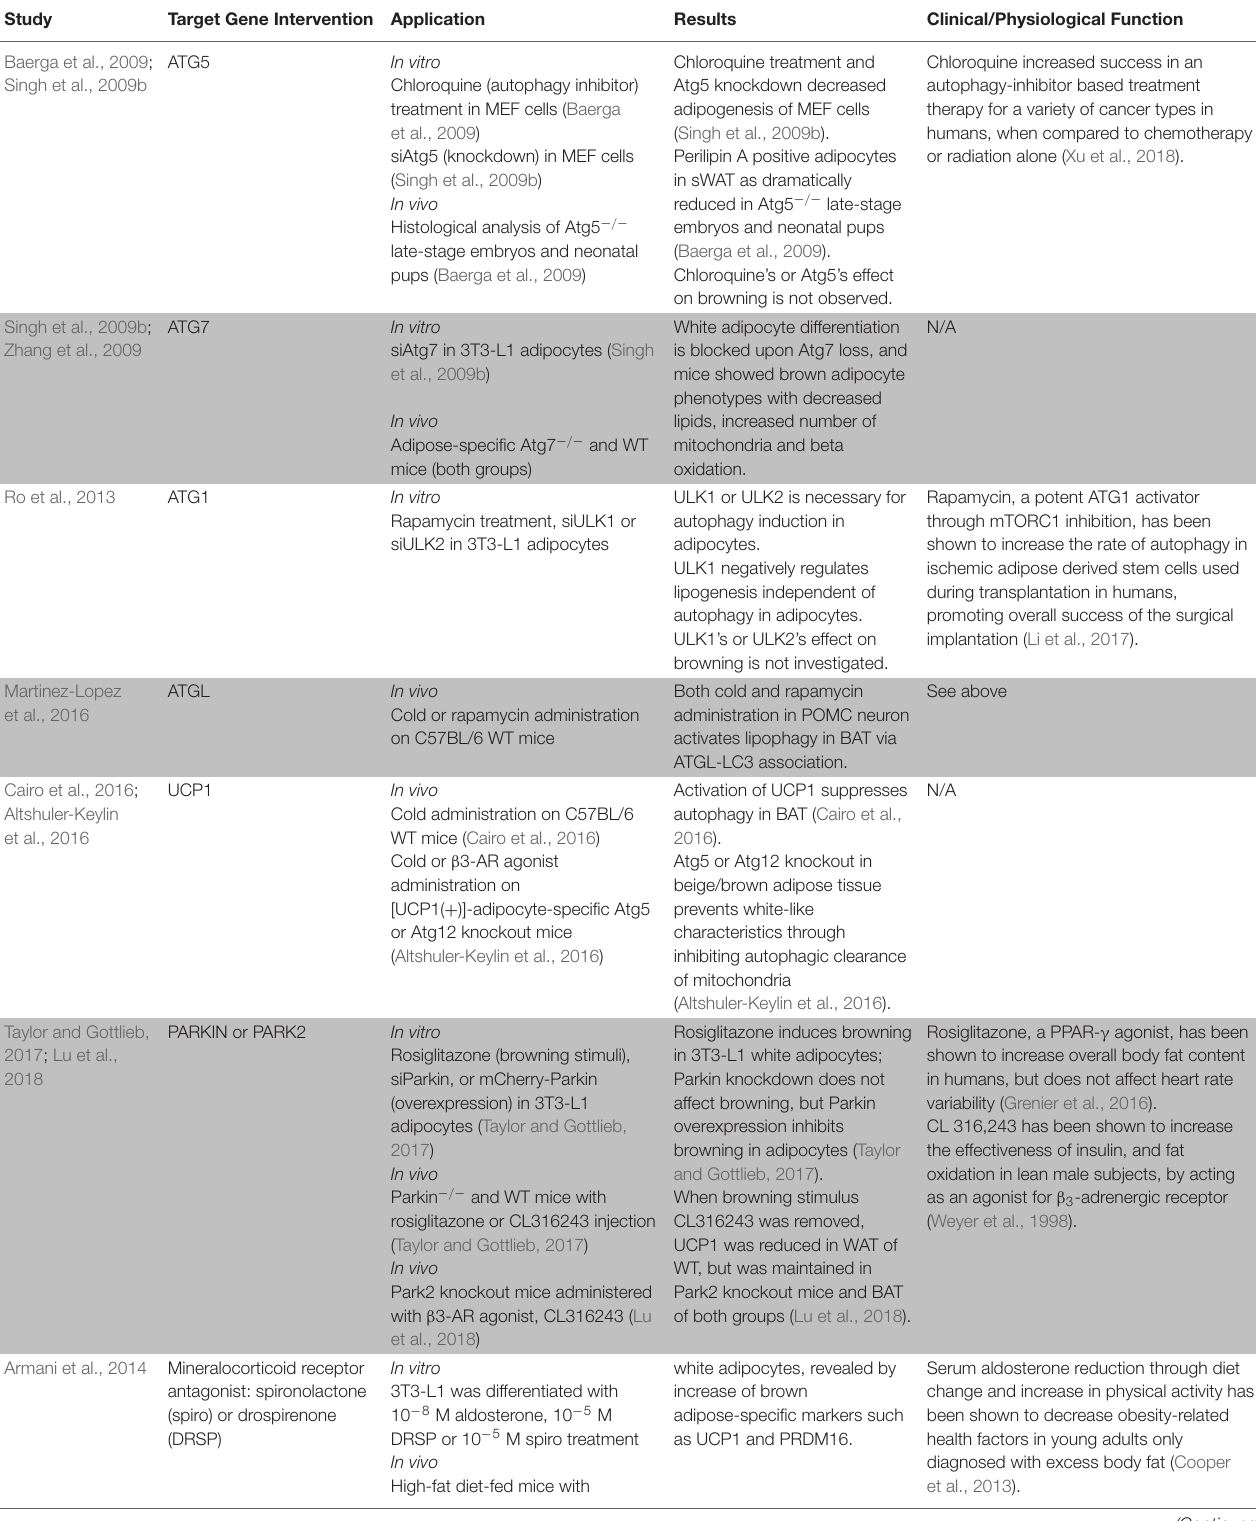
TABLE 1 | Summary of recent studies about the effect of direct autophagy gene manipulation or autophagy-related regulators on adipocyte browning.